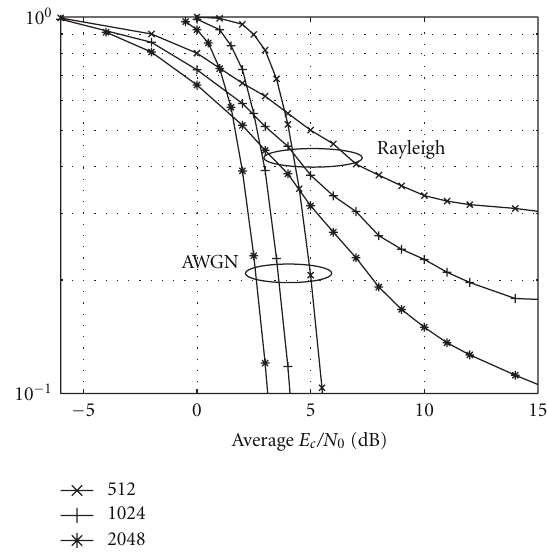
Figure 6: Codeword error rate performance results for codeword lengths of 512, 1024, and 2048 for two users on a quasi-static Rayleigh fading channel. The case with two users on the AWGN channel is included for comparison. In the AWGN case, the interfering user’s power is set to 0.9dB less than the desired